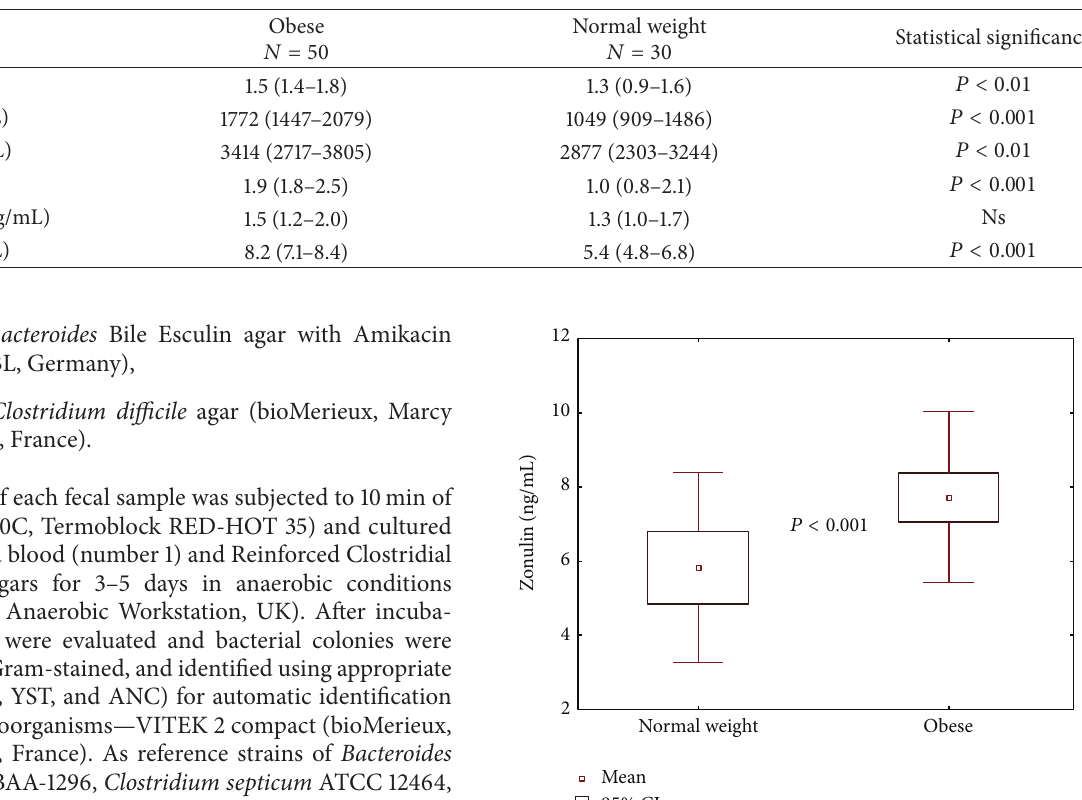
Table 2: The comparison of inflammation parameters in the study groups (median values with interquartile ranges).